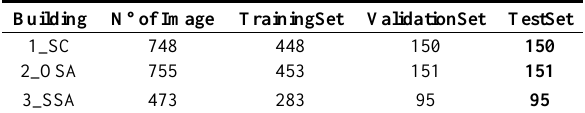
Table 1 . Number of images in Training Set, Validation Set and Test Set for each